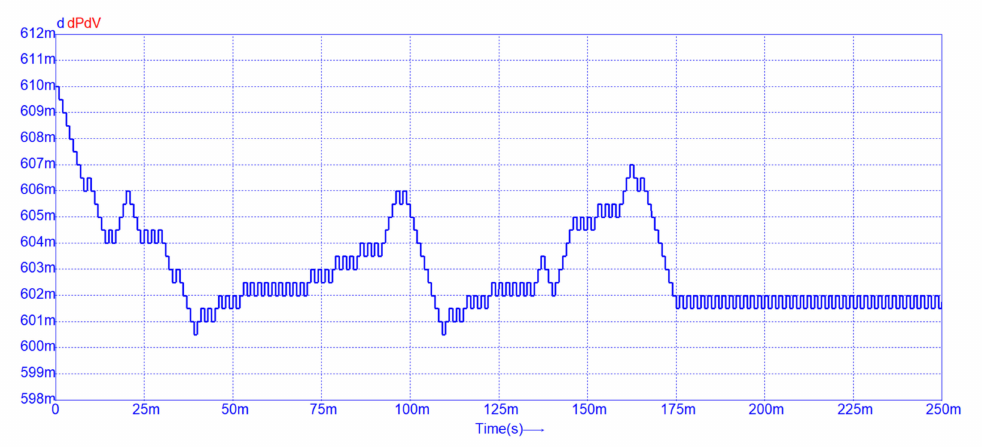
Figure 27. Duty cycle evolution against time for the proposed